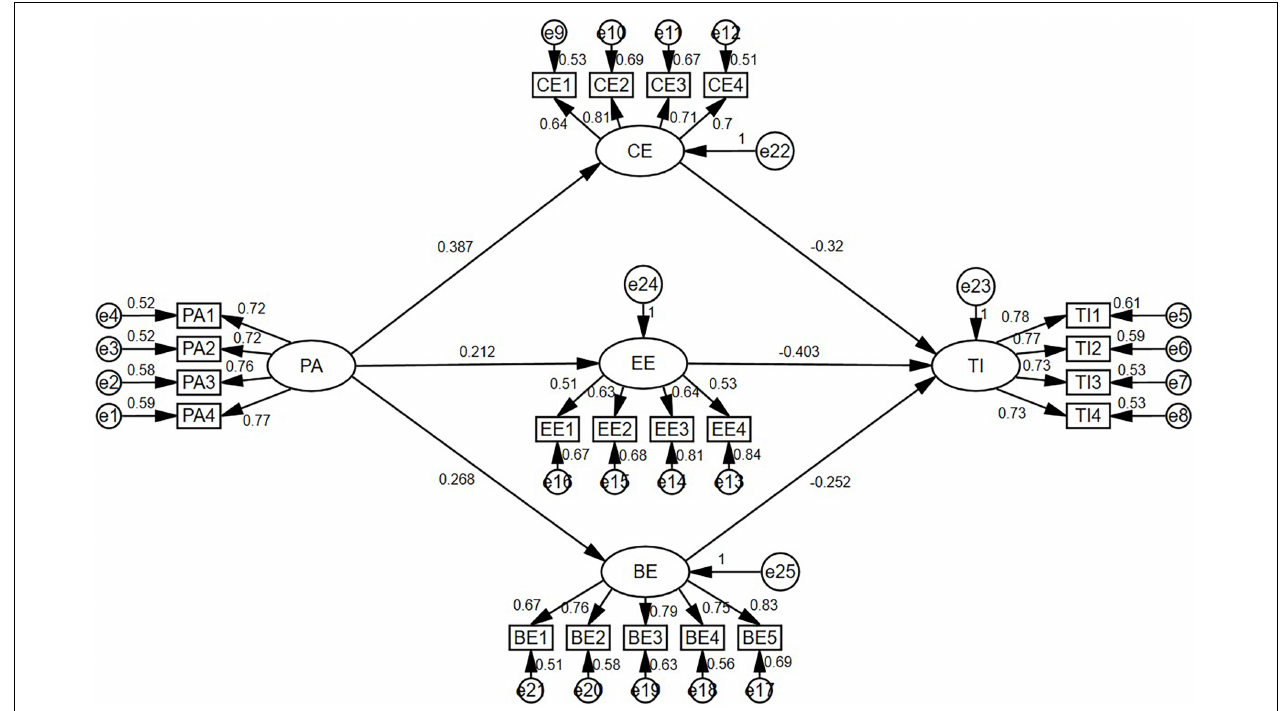
FIGURE 2 | Model fit analysis.